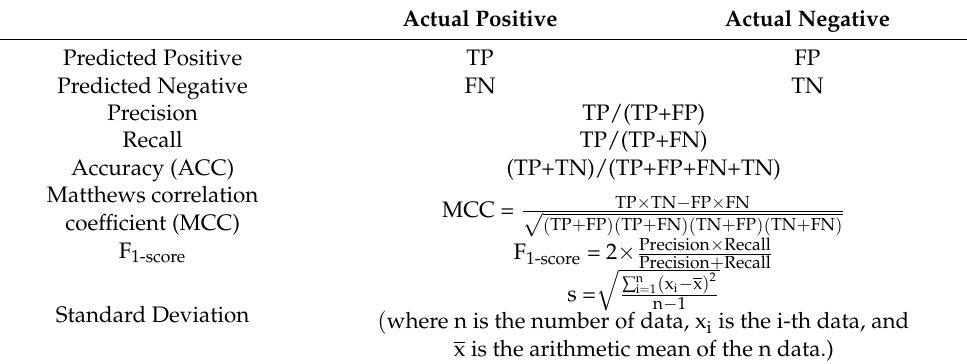
Table 2. Evaluation parameters used in this paper.